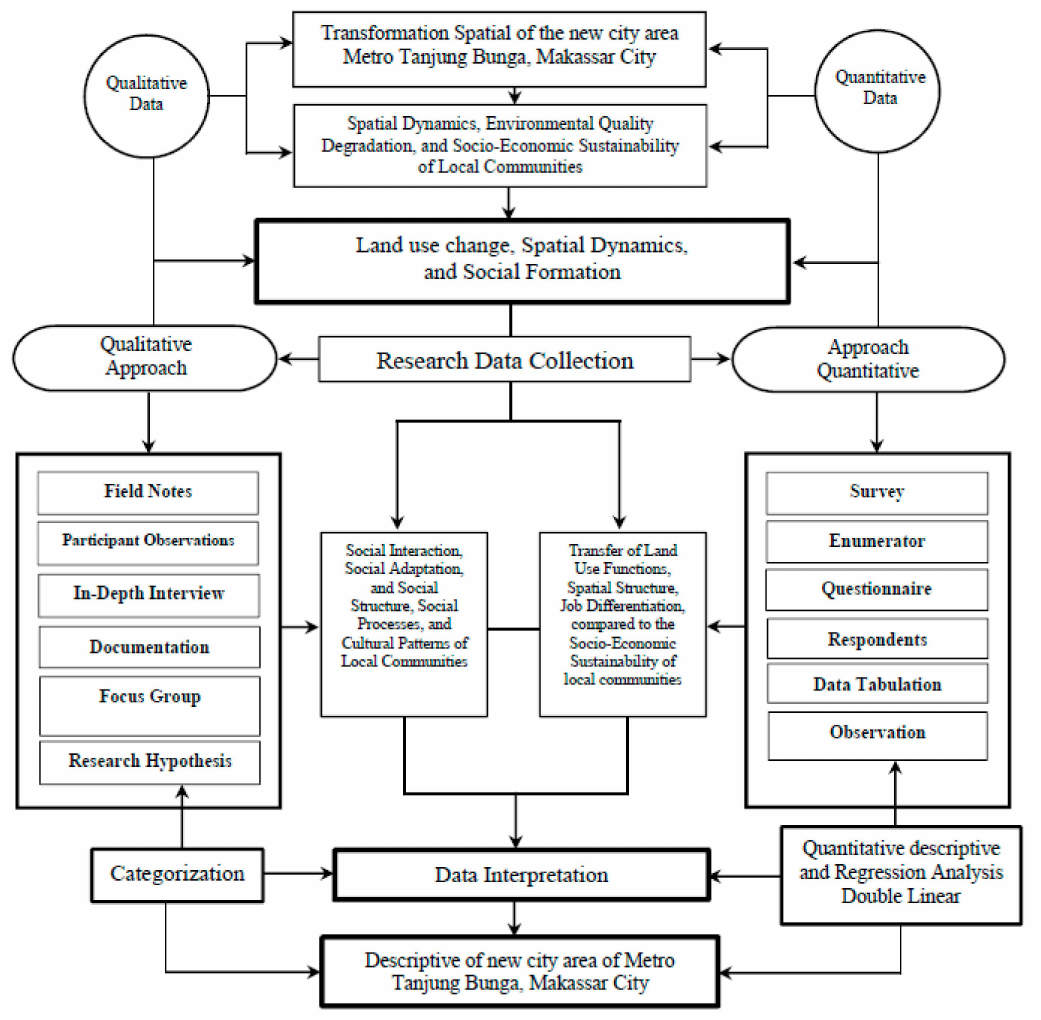
Figure 3. Research process implementation